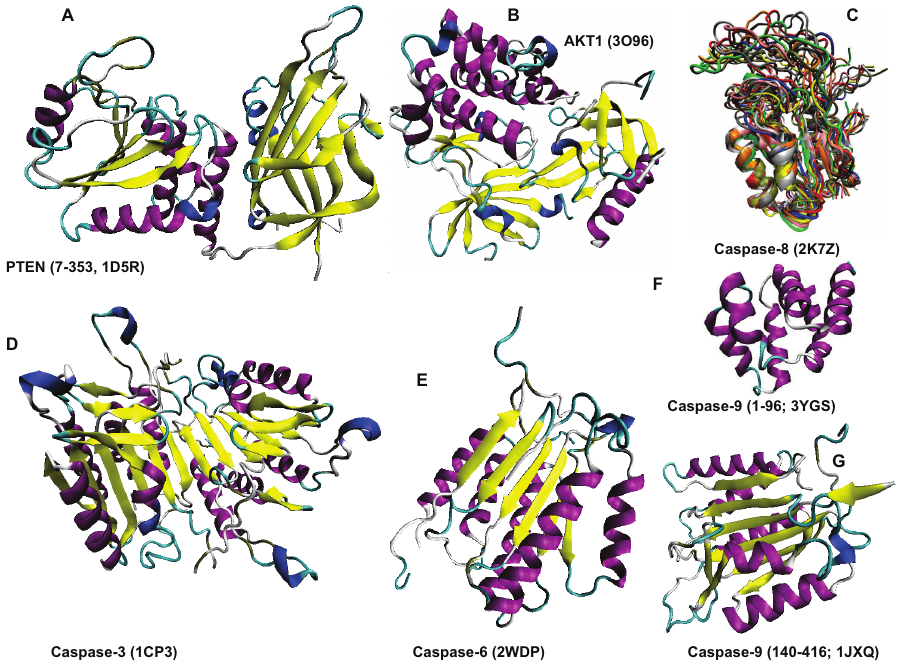
Figure 11. Structural characterization of human proteins involved in the p53-mediated apoptotic signaling pathways: group I. A . PTEN (PDB ID: 1D5R); B . AKT1 (PDB ID: 3O96); C . Caspase-8 (PDB ID: 2K7Z); D . Caspase-3 (PDB ID: 1CP3); E . Caspase-6 (PDB ID: 2WDP); F . Caspase-9 (Residues 1–96; PDB ID: 3YGS); G . Caspase-9 (Residues 140–416; PDB ID: